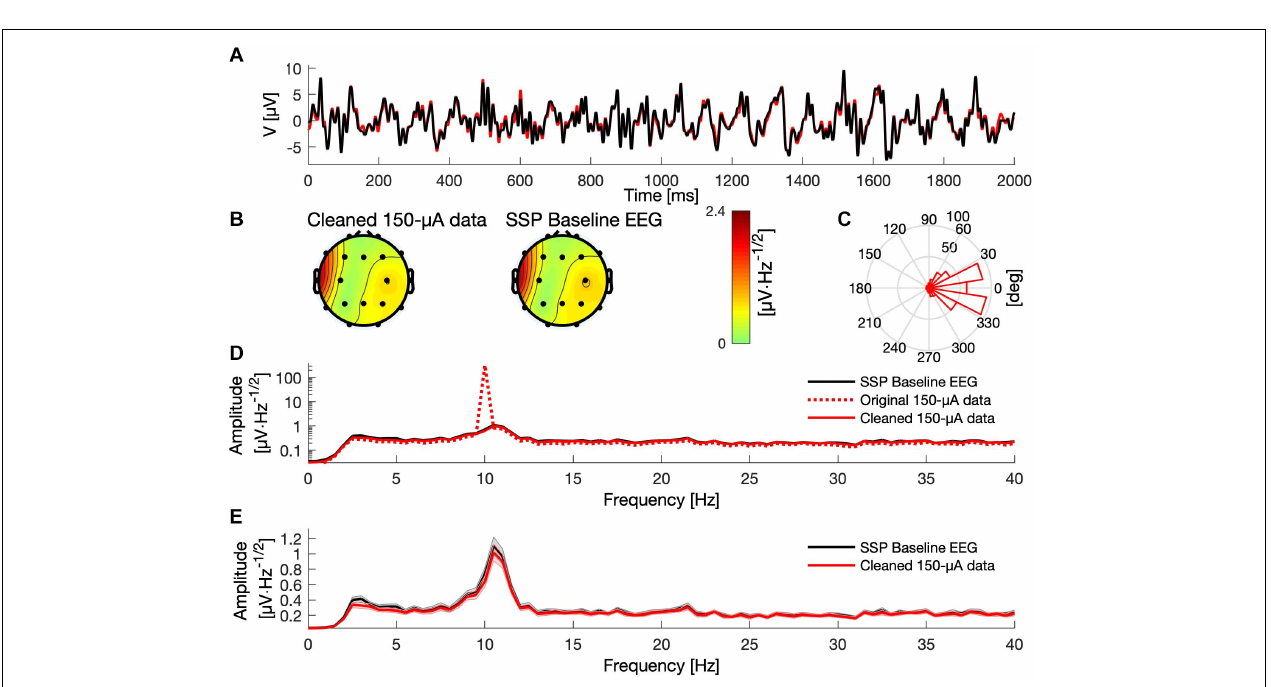
FIGURE 3 | Frequency spectra for each channel. (Left) The baseline data (black) are compared with the cleaned data after applying sine fitting (blue) and template subtraction (red). (Right) SSP baseline data (black) compared with the SSP cleaned data (green). Here, 150- µ V stimulation was delivered at 10 Hz.